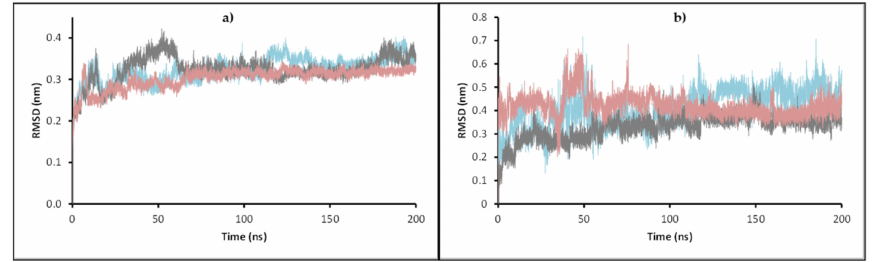
Figure 7. RMSD of enoyl-ACP reductase ( a ) and RMSD of the ligands ( b ) during the 200 ns simula- tions: 11c is present in cyan, 11d in gray, and 11e in pink.